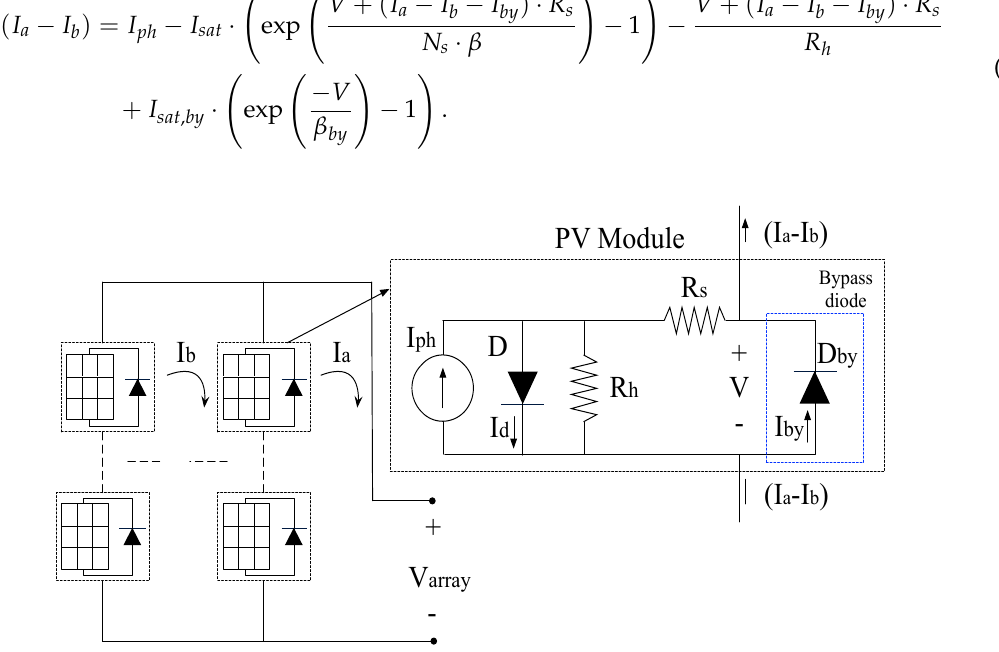
Figure 2. Single diode model equivalent circuit including the bypass diode D by